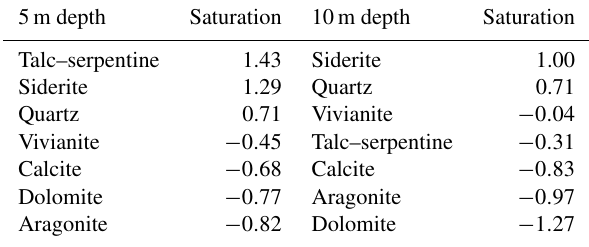
Table 1. Modeled saturation indices based on pH, alkalinity, pore water concentrations of major ions and borehole temperatures. Siderite appears to be oversaturated throughout the sedimentary se- quence, whereas vivianite remains close to but slightly below satu- ration with sediment depth. 5m depth Saturation 10m depth Saturation Talc–serpentine 1.43 Siderite 1.00 Siderite 1.29 Quartz 0.71 Quartz 0.71 Vivianite − 0 . 04 Vivianite − 0 . 45 Talc–serpentine − 0 . 31 Calcite − 0 . 68 Calcite − 0 . 83 Dolomite − 0 . 77 Aragonite − 0 . 97 Aragonite − 0 . 82